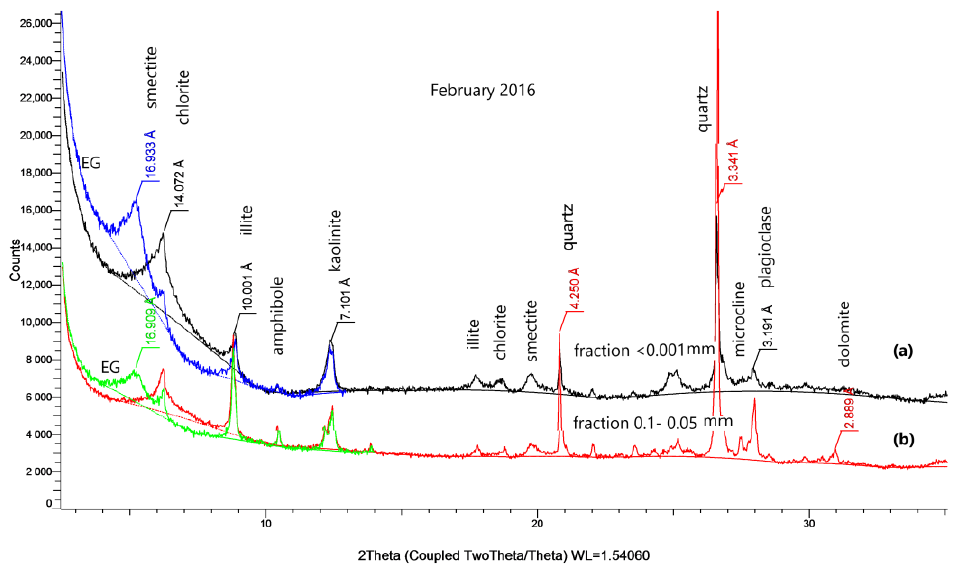
Figure 7. Fragments of X-ray diffraction patterns of suspended matter of Severnaya Dvina. River: ( a ) <0.001 mm fraction; ( b ) − 0.1 – 0.05 mm fraction. EG — fragments of diffraction patterns of the same samples saturated with ethylene glycol for the identification of smectite.